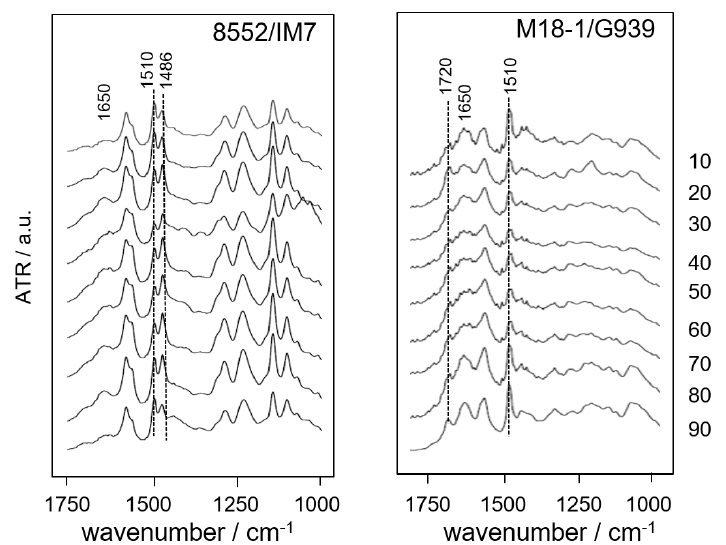
Figure 10. ATR-FTIR-spectra recorded along the middle of the backside (given distance from the edge in mm, see Figure 3) of 2 mm thick 8552/IM7 (left) and M18-1/G939 (right) specimens with marked characteristic bands for EP (1510 cm − 1 ), PES (1486 cm − 1 ), and PEI (1720 cm − 1 ) after impact of 10 g fire accelerant (spectra are vertically shifted).